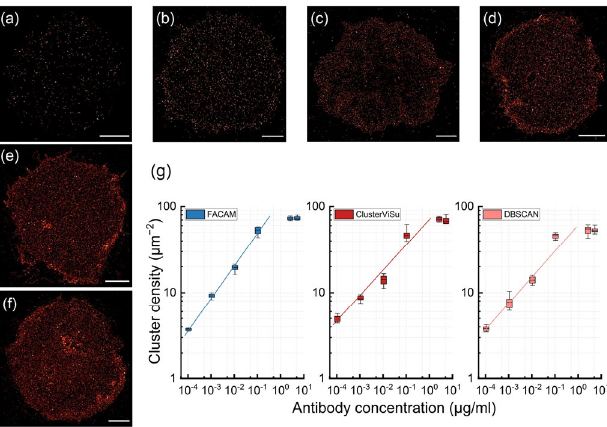
Figure 8. The dependence of cluster density on antibody concentration. ( a – f ) Reconstructed super- resolution images of CD138 at different antibody concentrations. From ( a ) to ( f ): 1.07 × 10 − 4 µ g/mL, 1.07 × 10 − 3 µ g/mL, 1.07 × 10 − 2 µ g/mL, 1.07 × 10 − 1 µ g/mL, 2.675 µ g/mL, and 5.35 µ g/mL, respectively. Scale bar: 4 µ m. ( g ) The dependence of cluster density on antibody concentration, using FACAM (blue) and ClusterViSu (red) as the clustering method. Boxplots were used for the statistics, and a linear fit to the median values of the first four boxes is performed. Note that the coordinates are both logarithmic (base